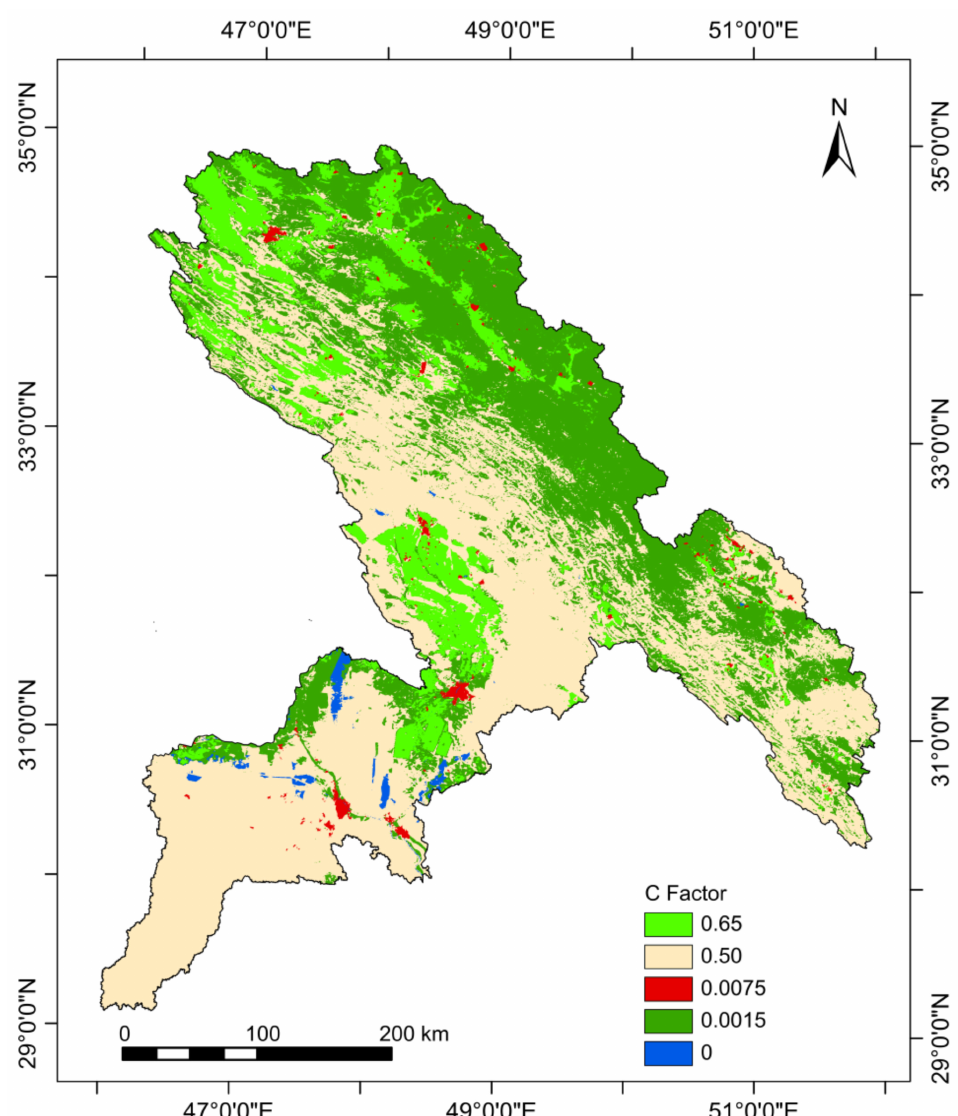
Figure 6. Spatial distribution of C factor in the study